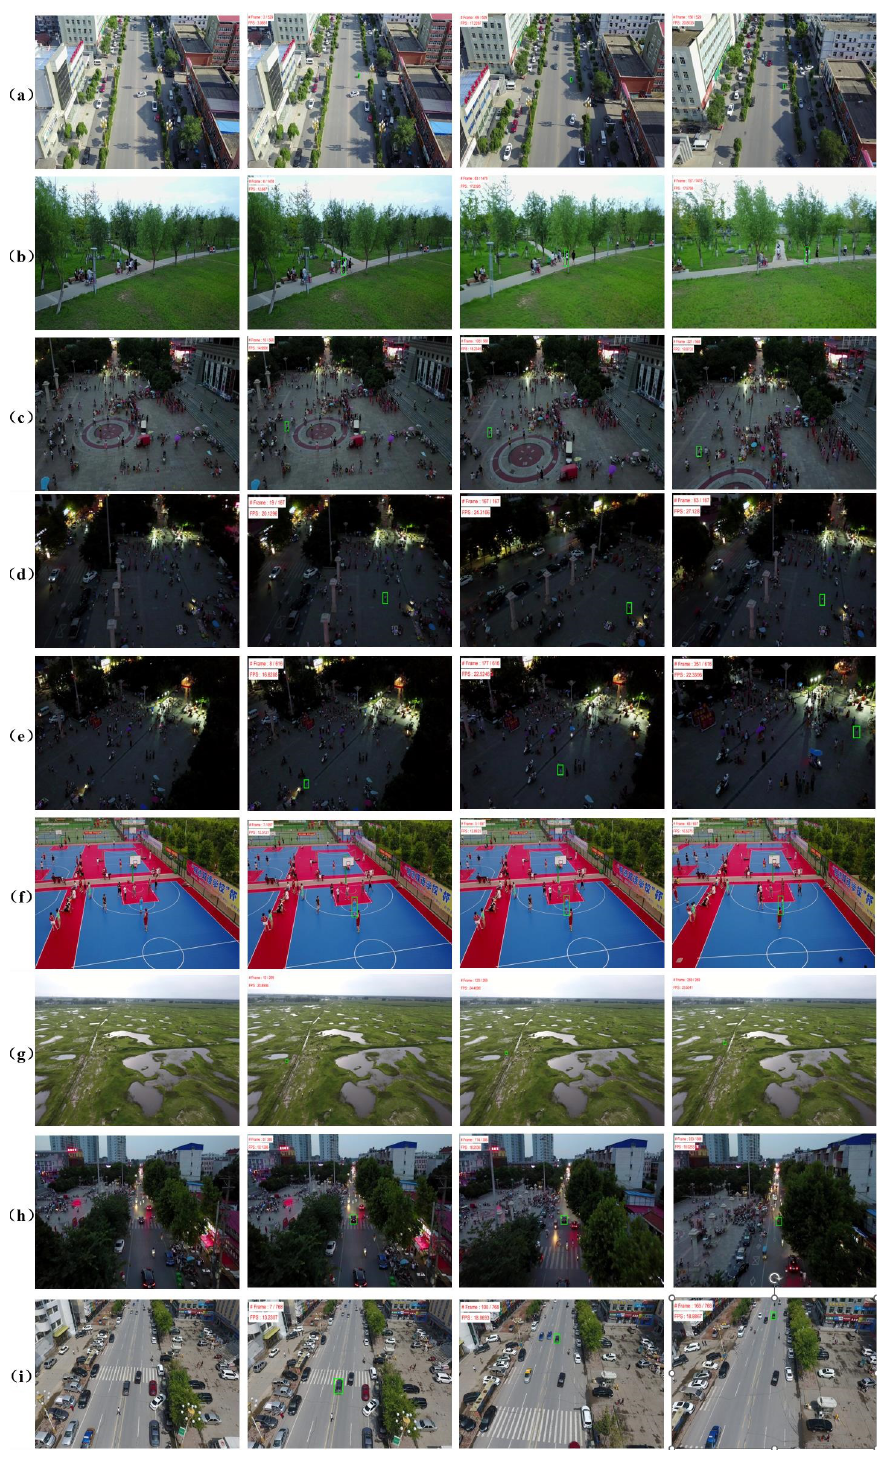
Figure 2. Visualization results of the algorithm under different conditions. The leftmost figure shows the original image in the dataset, and the right three figures show the resultant video frames of the tracking model. ( a , i ) shows the tracking effect when the light is sufficient and the targets are small in scale; ( b , f ) shows the tracking effect when the light is sufficient and the targets are obscured; ( c , h ) shows the tracking effect when the light is insufficient and the targets are dense; ( d , e ) shows the tracking effect when it is dark and the targets are small in scale; ( g ) shows the tracking effect when the targets are sparse and too small in